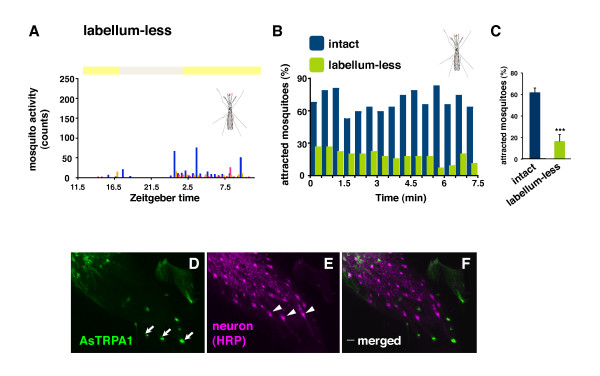
Labellum of the mosquito proboscis contributes to host-seeking behavior. (A-C) A possible role for the mosquito labellum as a thermo-detector. Note that the ability of labellum-less mosquito to recognize pseudo-targets (A) and real hosts (B) is reduced (C) (***p < 0.001, t-test; mean ± SD, n = 4). (D-F) AsTRPA1 is expressed on the labellum. Scale bars: 5 μm.